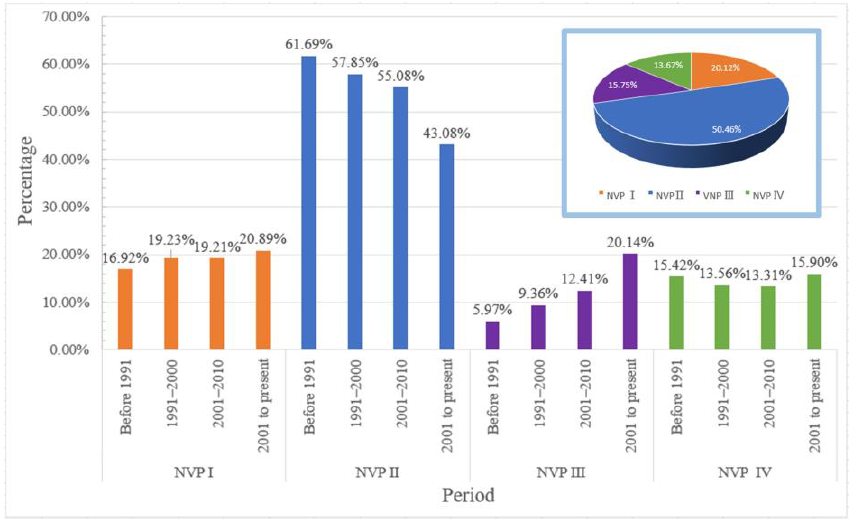
Figure 5. Percentage and change in residential areas with different levels of NVP in